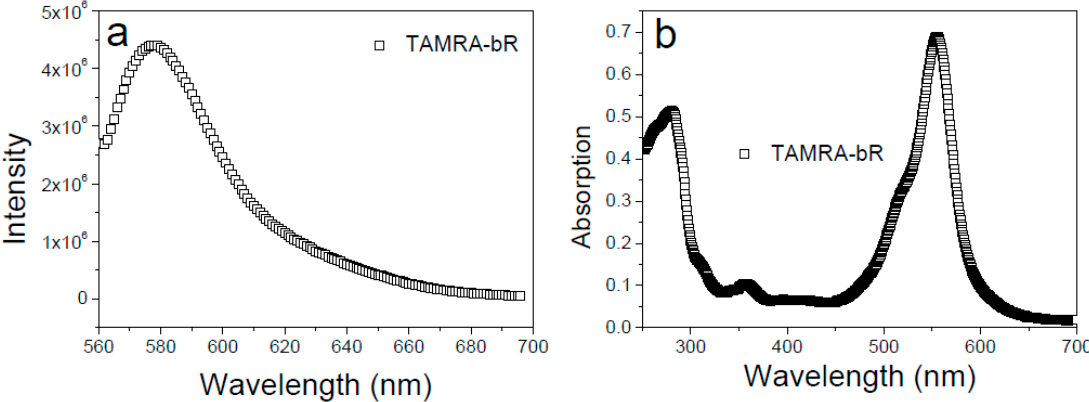
Figure 2. Fluorescence spectra ( a ) and UV-Vis absorption spectra ( b ) of bR proving its successful labeling with TAMRA.